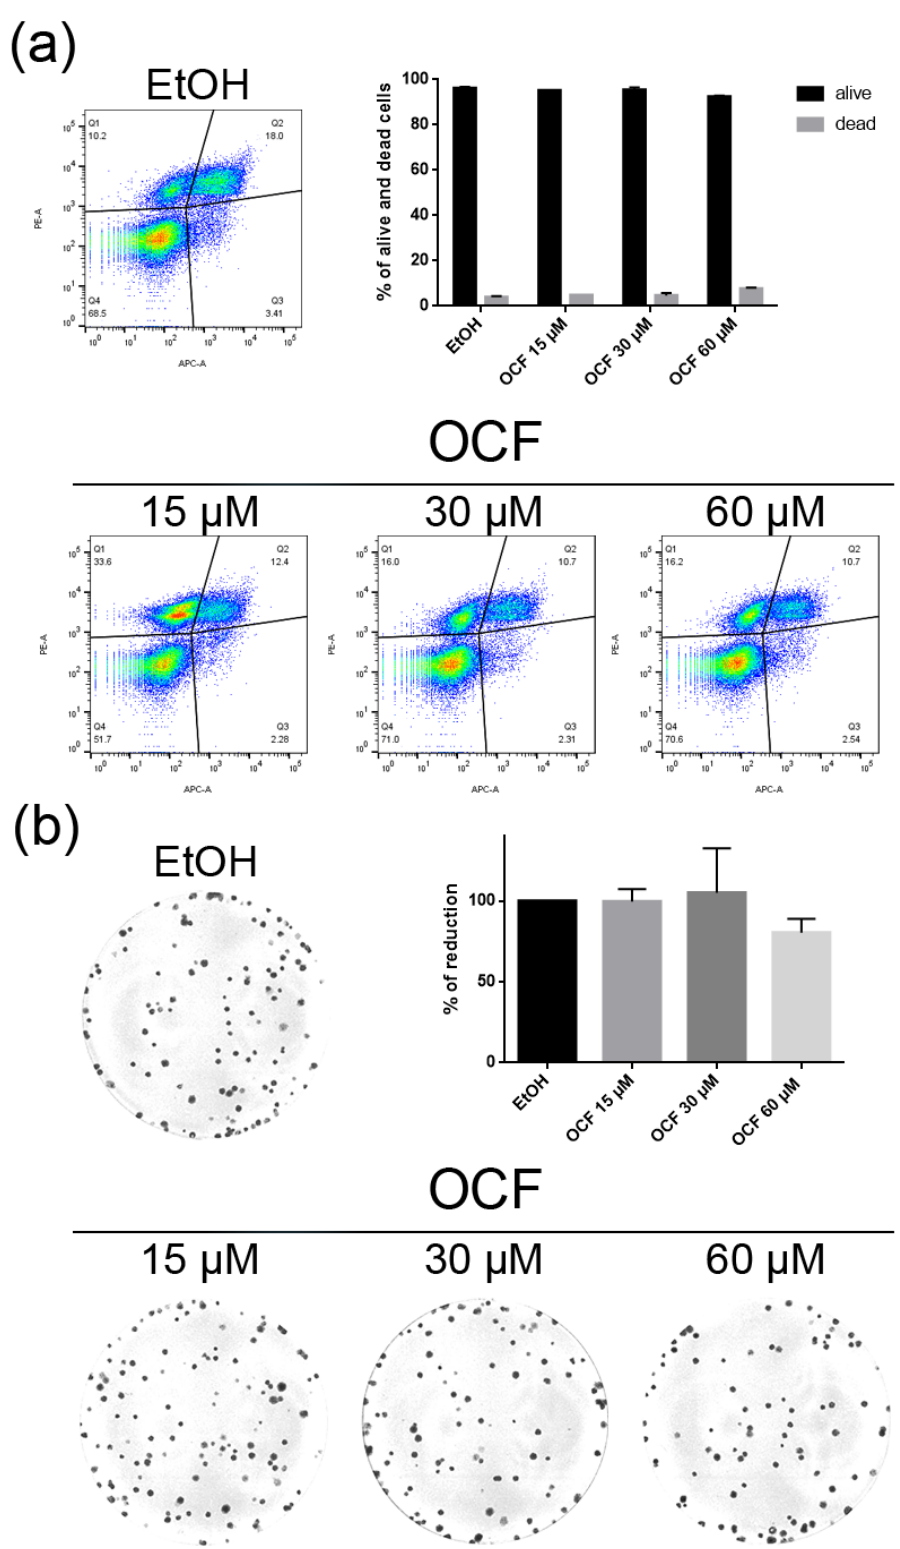
Figure 9. Vitality and the colony formation assay of the OCF-treated CISr cells. CISr cells were treated for 72 h with vehicle or with different doses of the OCF; plots and corresponding histograms for live/dead cells percentages obtained by an annexin V/PI double staining are shown ( a ). Cell colonies obtained after 72 h of the vehicle/OCF treatment and the corresponding percentage quantification ( b